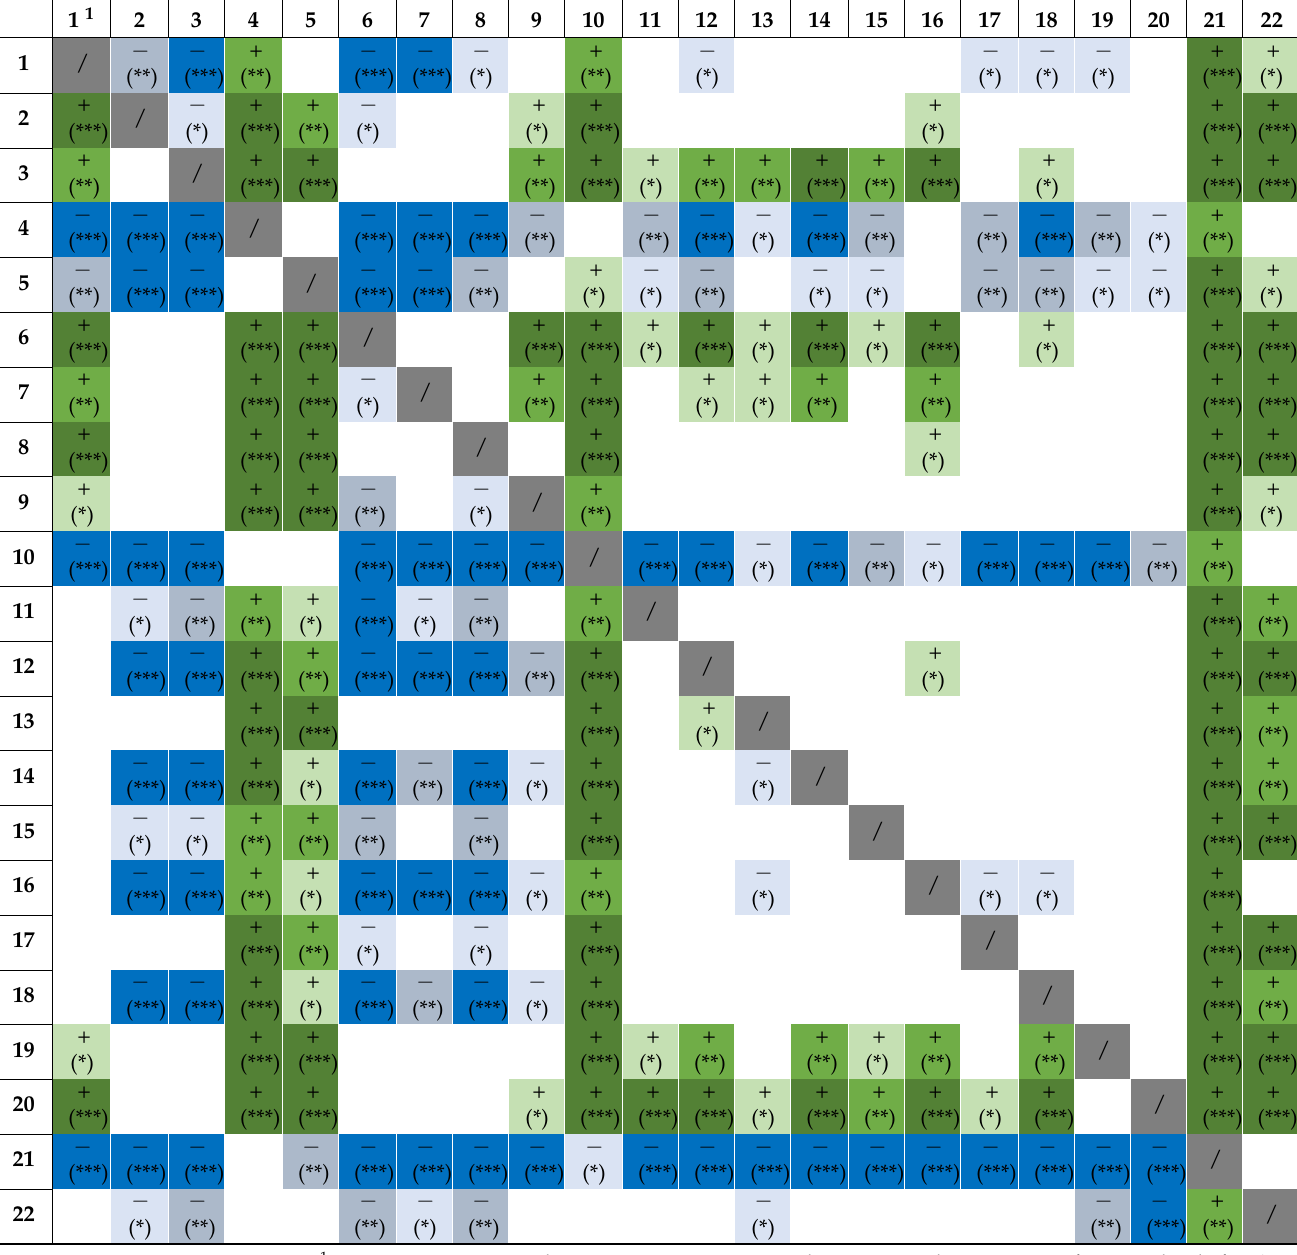
Table 12. The comparison of boat types’ influence on pacing strategy between Q3 and